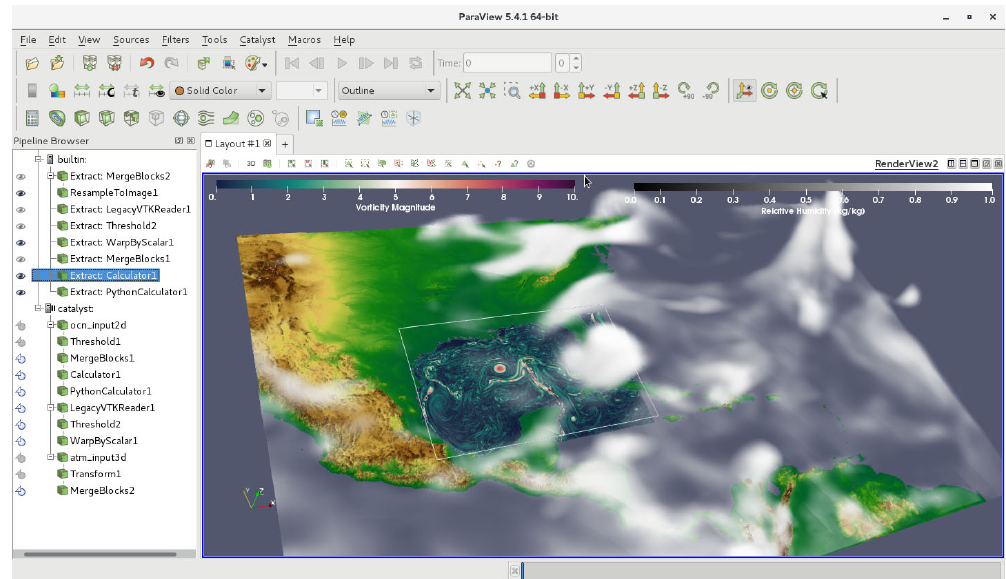
Figure 11. Volume rendering of atmospheric relative humidity field ( atm_input3d ) as well as the vorticity field in the ocean surface ( ocn_input2d ) from the COP_LR simulation using ParaView/Catalyst in live